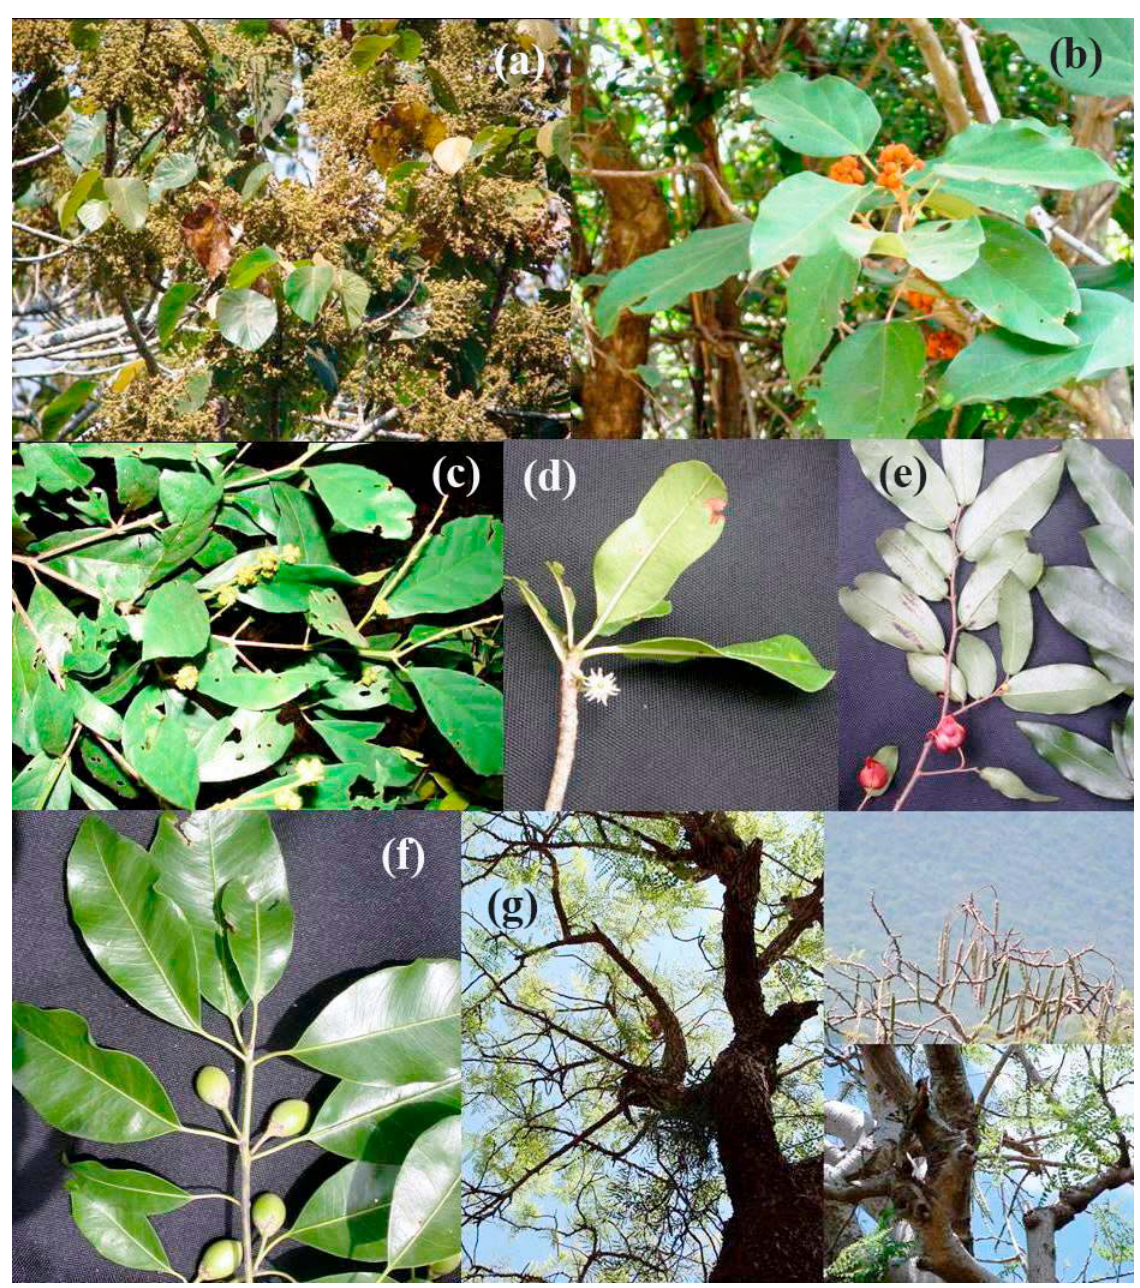
Figure 14. a) Macaranga indica (Euphorbiaceae); b) Mallotus philippensis (Euphorbiaceae); c) Mallotus stenanthus (Euphorbiaceae); d) Manilkara hexandra (Sapotaceae); e) Miliusa eriocarpa (Annonaceae); f) Mimusops elengi (Sapotaceae); g) Moringa concanensis (Moringaceae). Photo by L. Arul